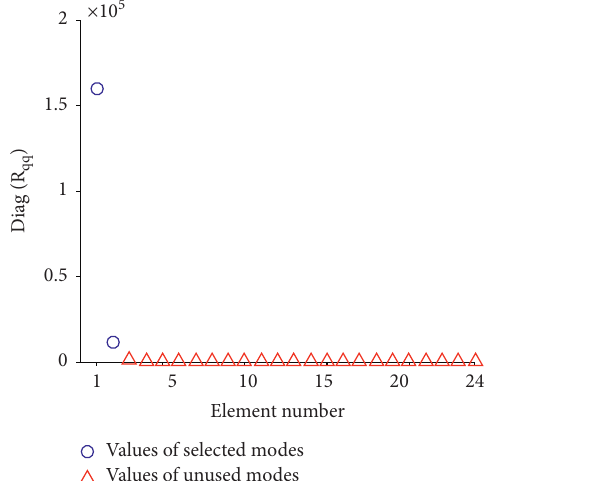
Figure 3: Diagonal element values of a simply supported beam with single damage (0.5% for the noise level). Table 3: Comparison of structural frequencies of the simply supported beam. Damage case Noise level